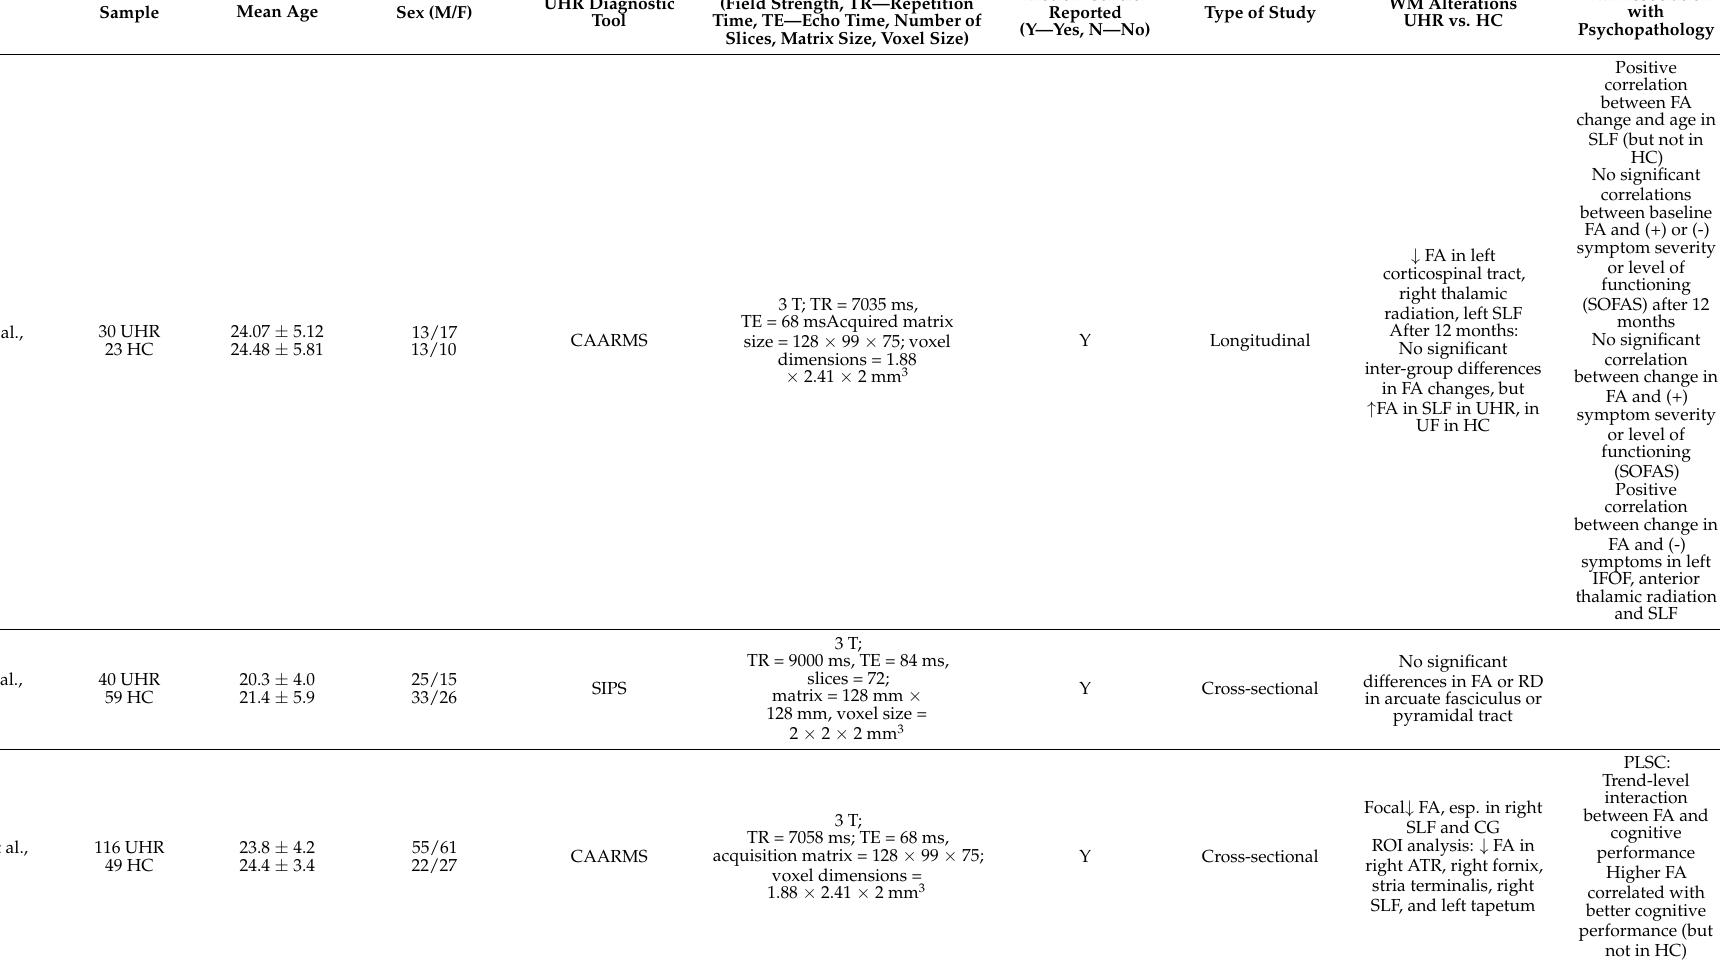
Cross-sectional